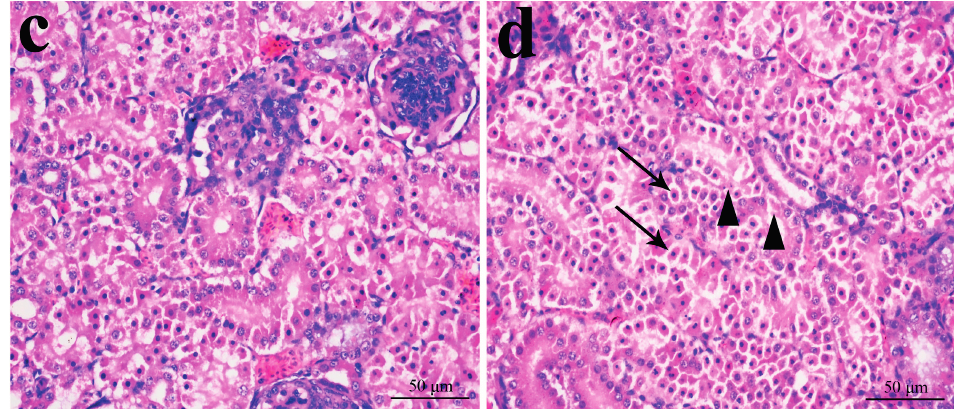
Figure 3. Histopathological changes in kidney at 28 days of age. ( a ) Control group. No changes are observed (H·E × 400); ( b ) 300 mg/kg group. Tubular cells show granular and vacuolar degeneration (H·E × 400); ( c ) 600 mg/kg group. Tubular cells show marked granular and vacuolar degeneration. Also, some necrotic tubular cells and apoptotic tubular cells are observed (H·E × 400); and ( d ) 900 mg/kg group. A large number of necrotic